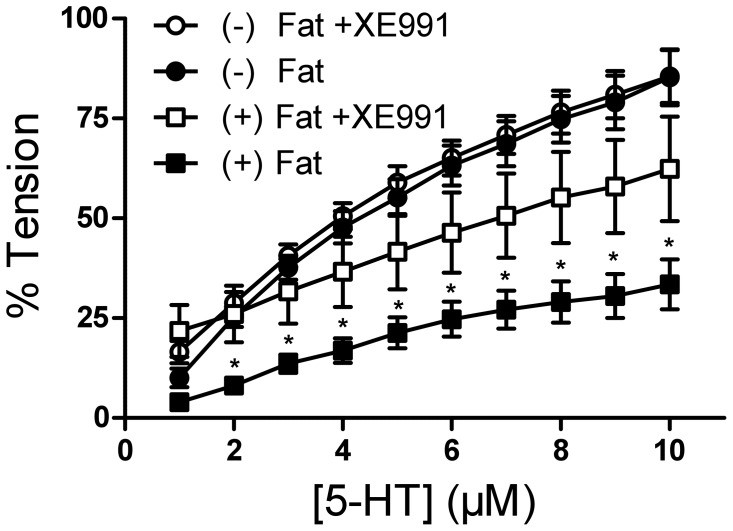
Serotonin (5-HT) dose response curves of rat aortic rings with ((+) Fat) and without ((−) Fat) perivascular fat with and without preincubation with XE991 (15 min, 30 µmol/l) in Mulvany Small Vessel Myograph.* p<0.05. n = 7 for all groups.